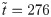
Test 3: FOM solutions for different testing-parameter instances.FOM solutions for μ = 12.9 ⋅ 0.0739 mm2/ms (left) and μ = 12.9 ⋅ 0.1991 mm2/ms (right) at t˜=276 ms. By increasing the value of μ the wavefront propagates faster.